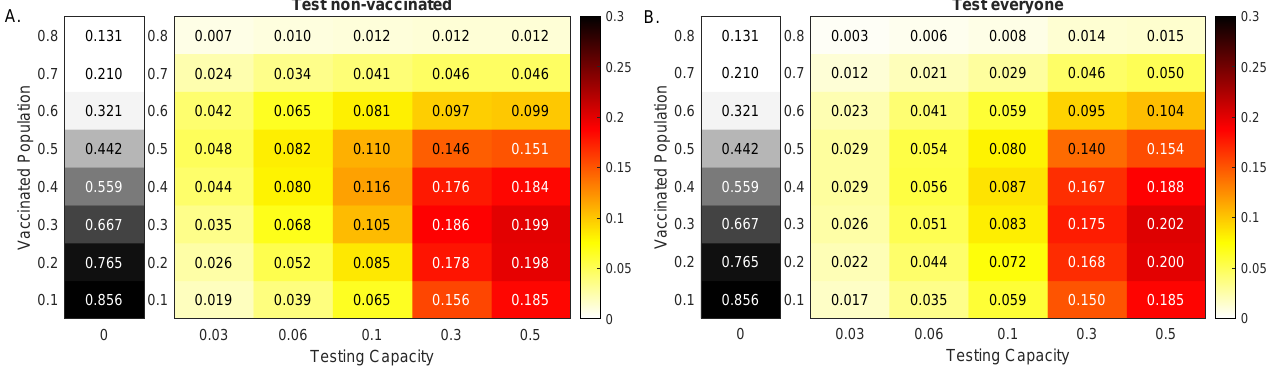
Figure 5. Reduction in Delta variant cases at 100 days. Heatmaps for the reduction in cumulative cases at 100 days after an outbreak with a Delta variant, Σ noTests ( 100 ) − Σ Tests ( 100 ) , as given by model Equation (1) versus RT-PCR testing capacity with a return delay of 1 day, C , and background vaccination levels, V 0 . Panel ( A ): Test non-vaccinated only; Panel ( B ): Test everybody. The gray heatmaps represent the cumulative cases at day 100 in the absence of testing, Σ noTest ( 100 ) . Parameters and initial conditions are given in Table